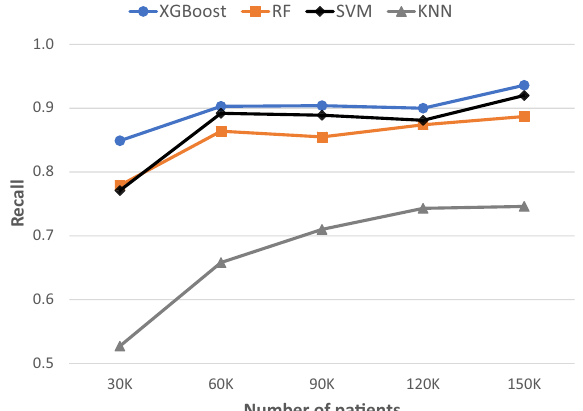
Figure 4. Continuous improvement of lung cancer risk prediction models with dataset size increase over time. Initial dataset: 30 K patients; 4 data updates, each with 30 K patients. Recall was used as the key performance measure for risk prediction in preventive screening. XGBoost base model was compared to the RF, SVM, and KNN base models at each instance of data update.